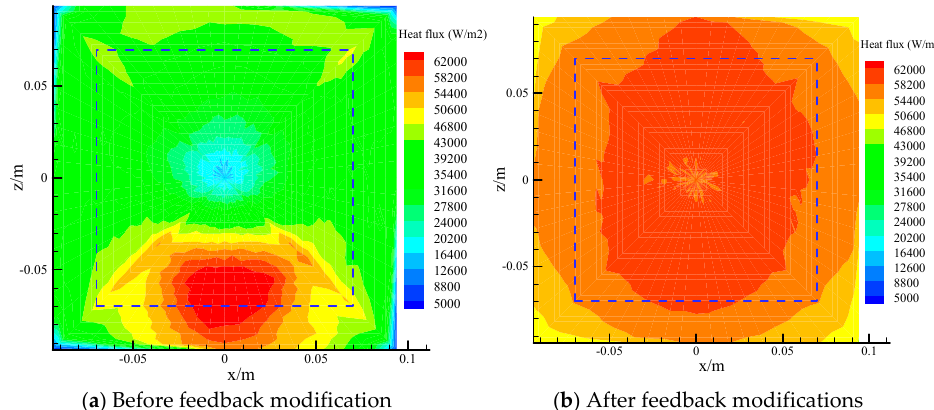
Figure 11. Heat flux distribution comparison on target surface.